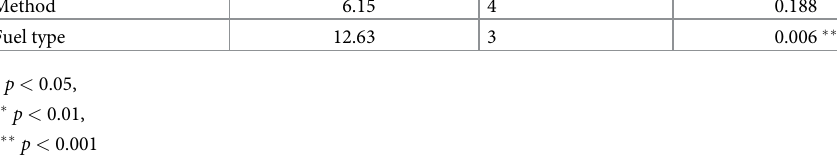
Table 7. Likelihood-ratio chi-square, degrees of freedom and p-values from the fitted Cox proportional hazards model analysis of deviance (Type II tests). Variable LR Chisq Df